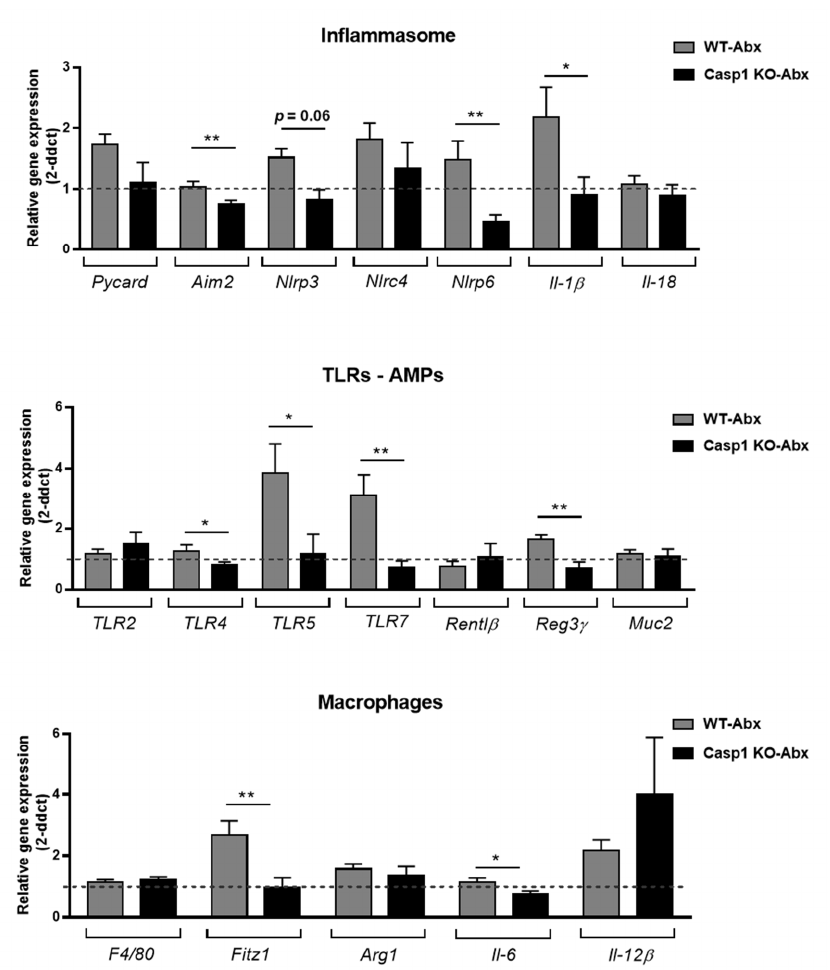
Figure 2. Representative RT-qPCR expression of genes associated with ( A ) inflammasome ( Pycard, Aim2, Nlrp3, Nlrc4, Nlrp6, Il-1 β and Il-18 ); ( B ) toll-like receptors ( TLR2, -4, -5 and -7 ); antimicrobial peptides (AMPs- Rentl β and Reg3 γ ), the mucus layer component Muc2 and ( C ) macrophage M1/M2 signature ( F4/80, Fitz1, Arg1, Il-6 and Il-12 β ), the colon of WT and Casp1 KO antibiotic-treated groups. Data are mean (SEM). n = 7–9/group. *: p < 0.05, **: p <0.001. Dashed line indicates a background value of 1 of WT and Casp1 KO-control groups. Abx: Antibiotic. Immunophenotyping of colonic lamina propria (LP) cells isolated from control and Abx-treated WT and Casp1 KO mice showed that the number CD45 + (leukocytes), neutro- phils (Ly6G + ), T cells (CD3 + ), dendritic cells (DCs, CD11c + /F4/80 − ) and macrophages (CD11c − /F4/80 + ), were reduced in Casp1 KO compared to the WT control group (Figure 3A–C,E,F). Abx-treatment was associated with a similar number of colonic LP CD4 + T cells and neutrophils and an increase in CD45 + cells, DCs (CD11c + /F4/80 − ) and macrophages (CD11c − /F4/80 + ) in the WT group but not in Abx-treated Casp1 KO group (Figure 3A,B,D– F). Overall, the data indicate an attenuation in intestinal immune responses in Casp1 KO mice with antibiotic-induced microbial changes. 1